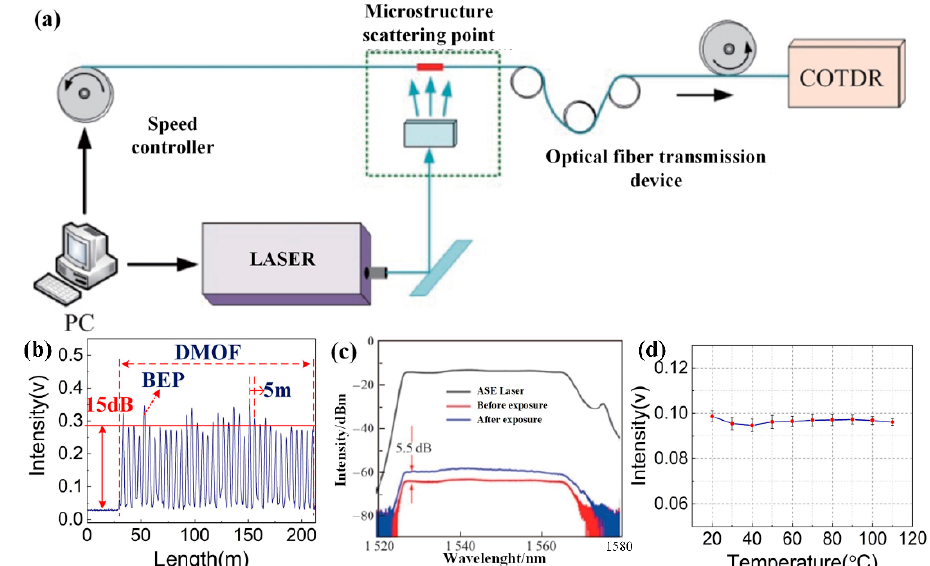
Figure 9. Preparation method for a colorless microstructure array based on UV exposure: ( a ) automatic colorless microstructure preparation system [51]; ( b ) OTDR measurement results of colorless microstructure array [53]; ( c ) spectra of colorless microstructure arrays [51]; ( d ) temperature stability of colorless microstructure arrays [53].